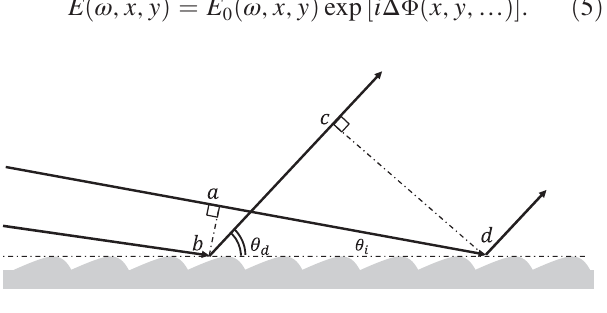
FIG. 3. Geometry of